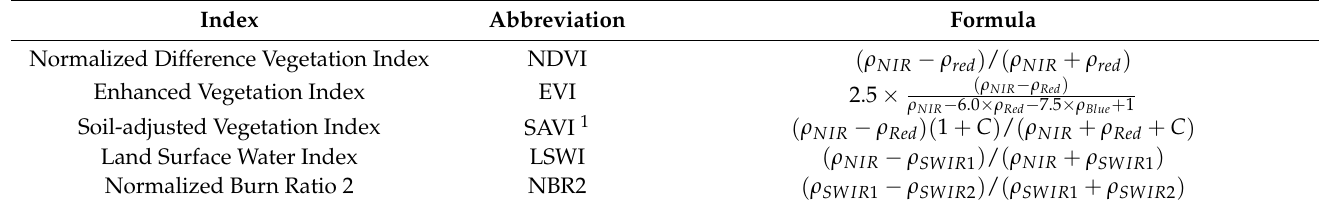
Table 4. Vegetation indexes used in the